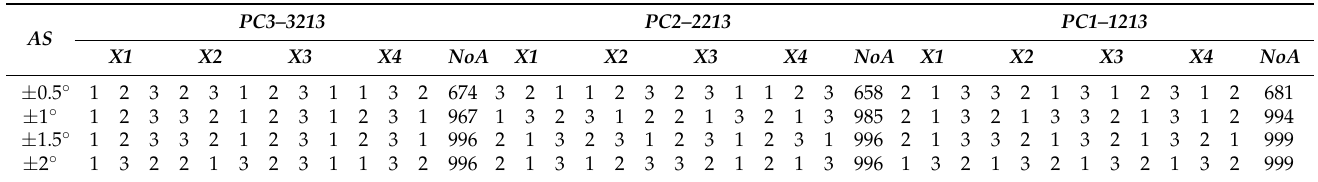
Table 15. Best bin combinations for various assembly specifications and process